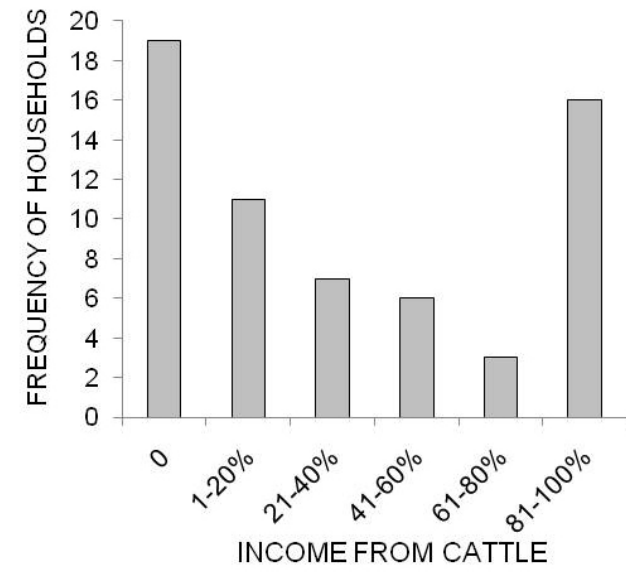
Fig. 4 . Percentage of income of the households that have ranching as their main activity ( n =